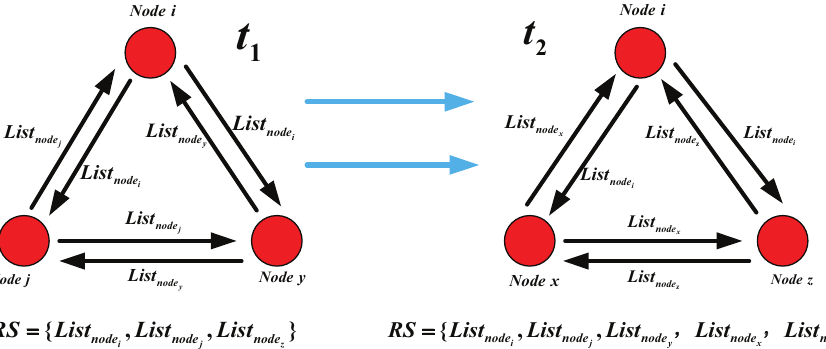
Figure 1. Collecting and updating network routing state during the phase T